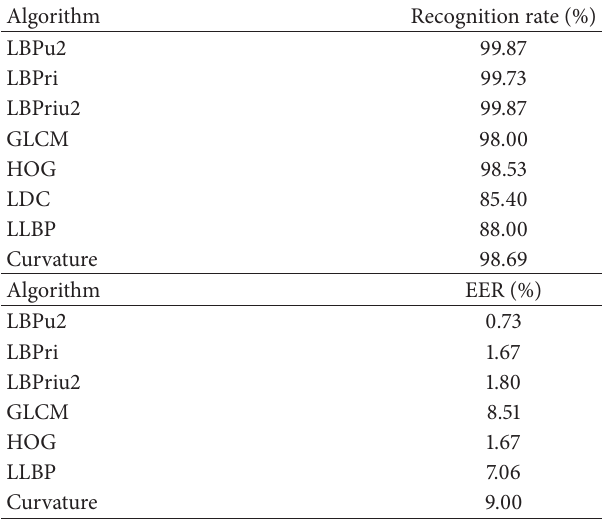
Table 2: Recognition results with comparison of algorithms and comparison of EER values using state-of-the-art algorithm.